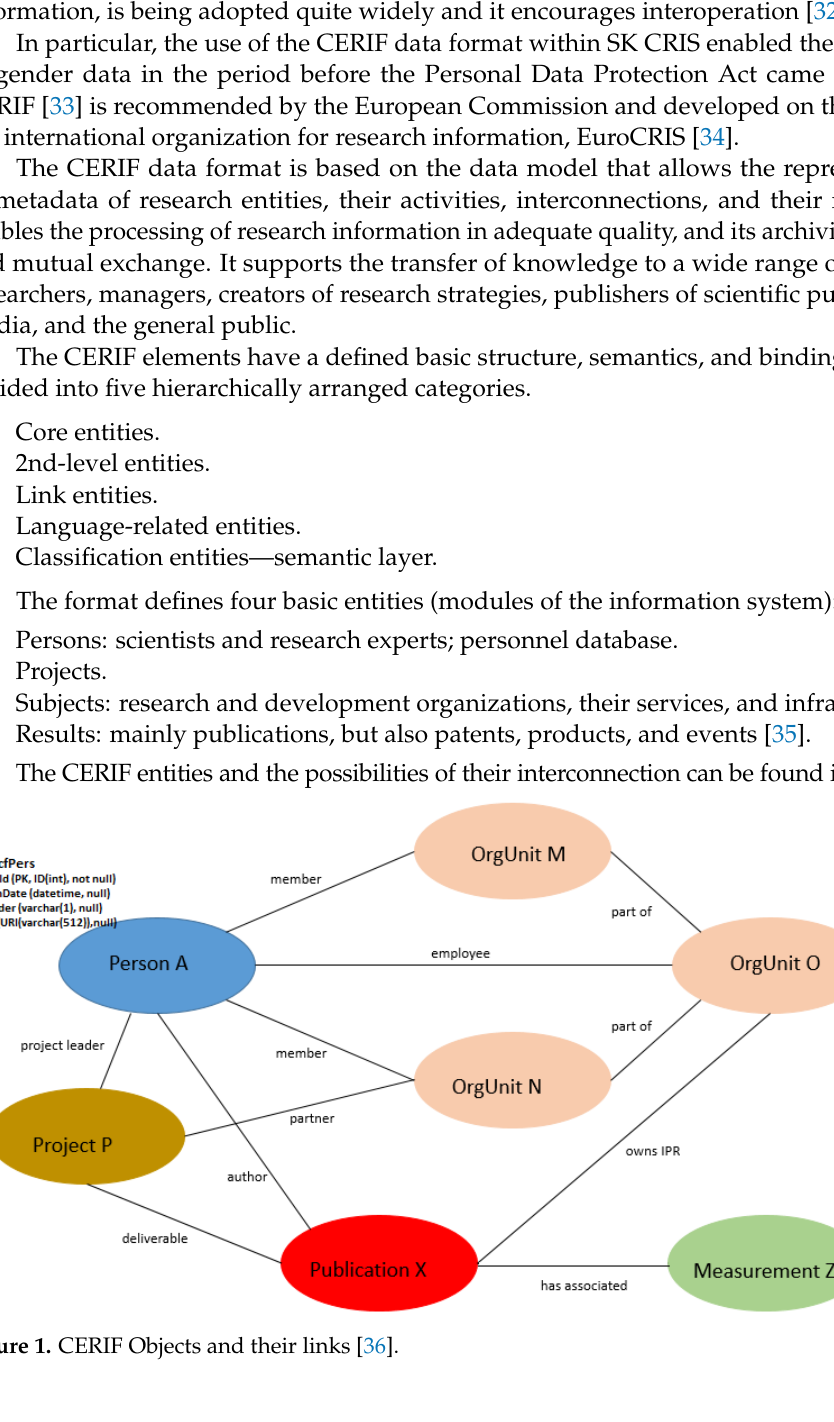
Figure 1. CERIF Objects and their links